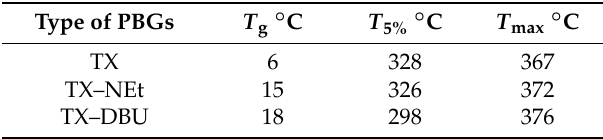
Table 1. Thermal data of photocured films with different PBGs.